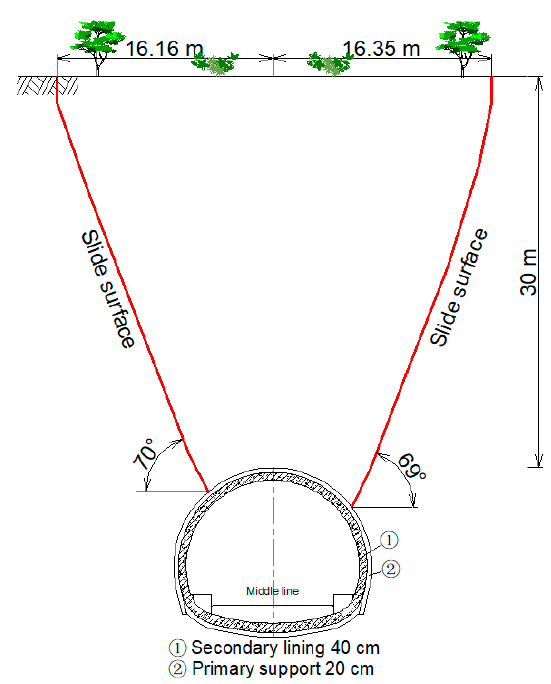
Figure 7. Slide surfaces in K1841 + 475~K1841 + 495.